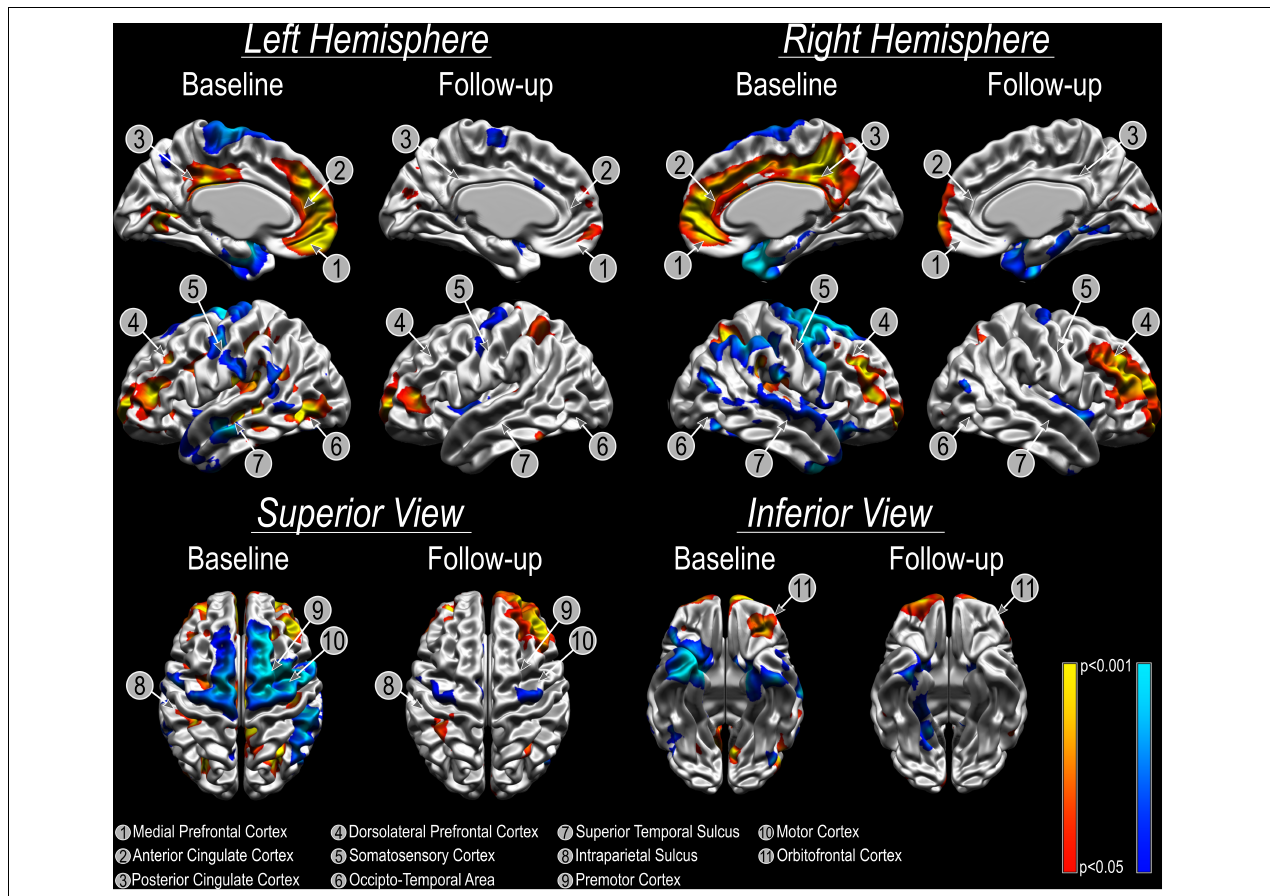
FIGURE 1 | Cortical thickness analysis using CIVET. Cold colors show areas where CT is reduced in patients with refractory aggressive behavior compared with patients with non-refractory aggressive behavior. Warm colors show local cortical thickness increases comparing patients with refractory aggressive behavior